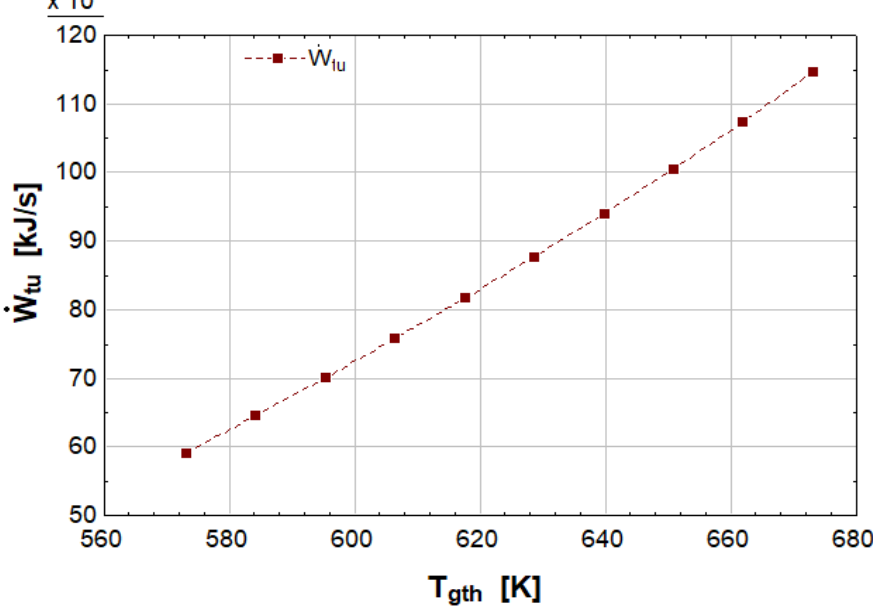
Figure 5. Effect of Geothermal Source Temperature on Turbine Work Output.